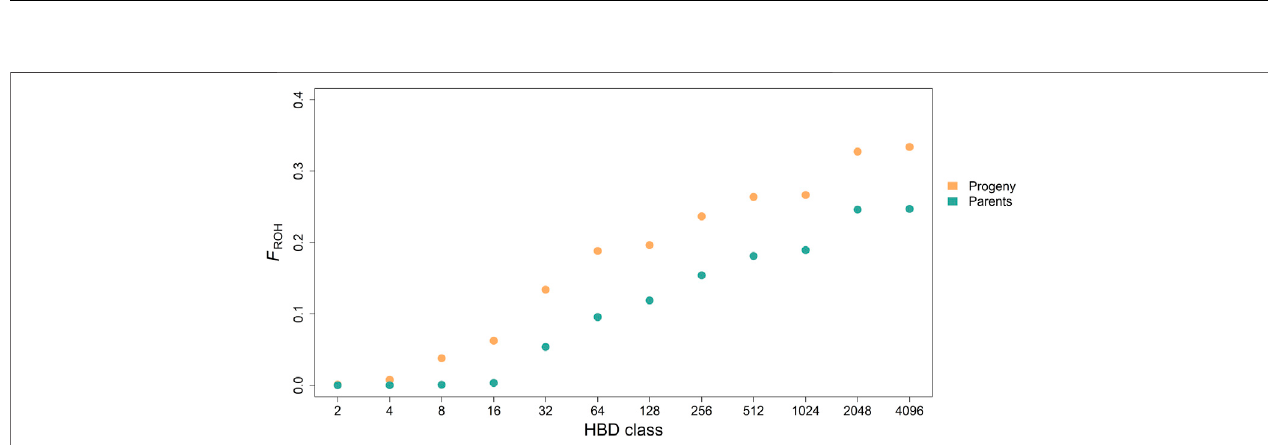
FIGURE 2 | Distribution of the average number of runs of homozygosity (ROH) per individual for the different homozygous-by-descent (HBD) classes per chromosome inthe progeny and parental generation. The height ofthe bar represents theaveragenumber of ROHsegmentsassociated with thedifferent HBD classes of the corresponding color. Chromosomes are ordered by physical length, longest chromosome at fi